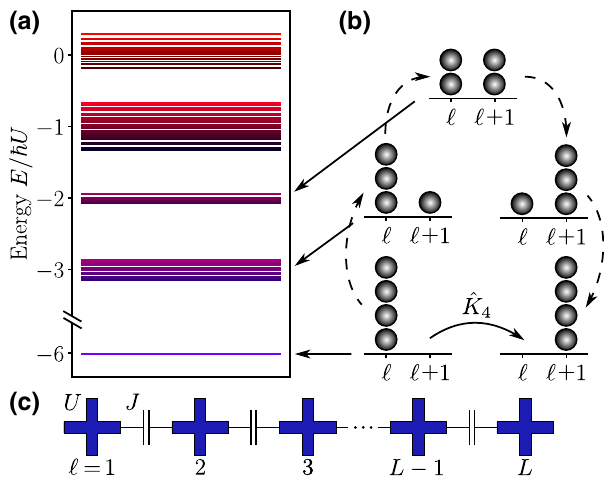
FIG. 1. (a) Energy-level spectrum of a transmon chain of length L = 6 containing a total of N = 4 bosons, as described by the attractive Bose-Hubbard model (1). In this work, we are inter- ested in the many-body dynamics beyond the hard-core bosons, meaning that we consider also the states below the topmost energy band. (b) Schematic representation of an effective hop of a stack of bosons described by the operator ˆ K 4 [see Eq. (7)] within the lowest anharmonicity manifold, together with the vir- tual hops through the higher manifolds involved in the process. (c) Schematic of a chain of L capacitively coupled transmons.